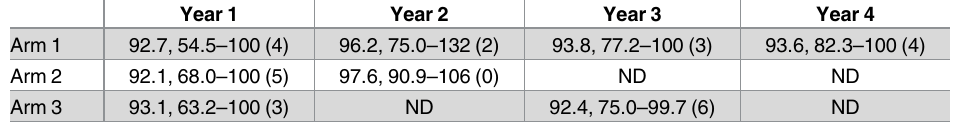
Table 4. Mean treatment coveragepercentage, range, and number (n) of schools with less than 90% coveragein each arm in each year.